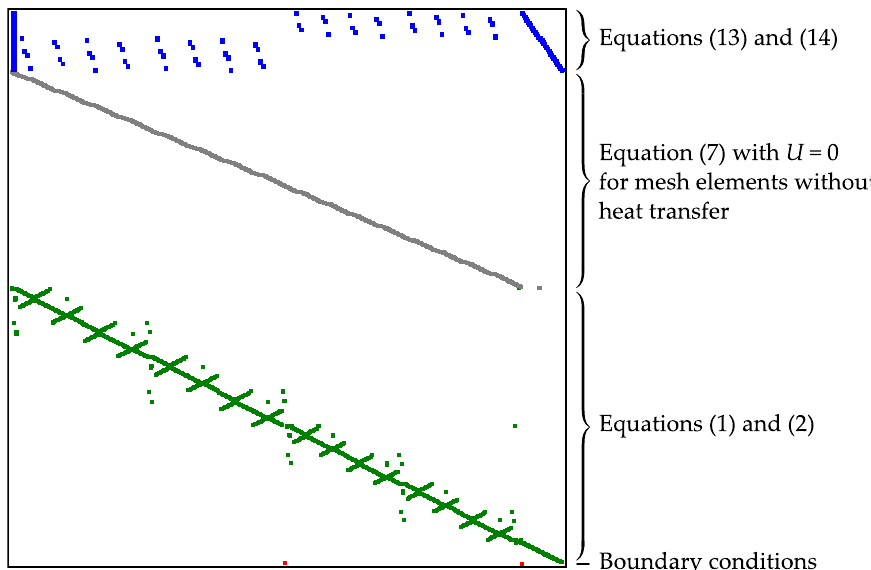
Figure 6. Non-zero values in the sparse temperature field matrix used in the second step of the FEA solver. Please note that, for the sake of clarity, only a small matrix with the rank slightly below 800 is shown here, which originates from a flow distribution system with two bundles consisting of just four tubes each.